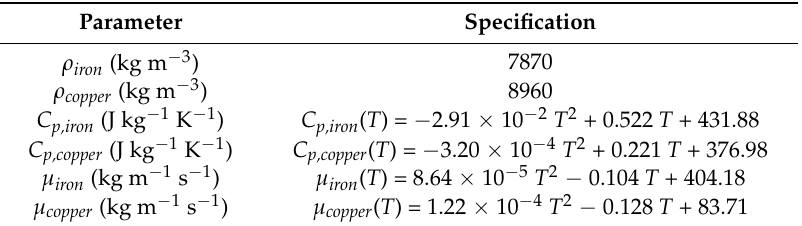
Table 1. Thermal Parameters of Core and Winding Materials.